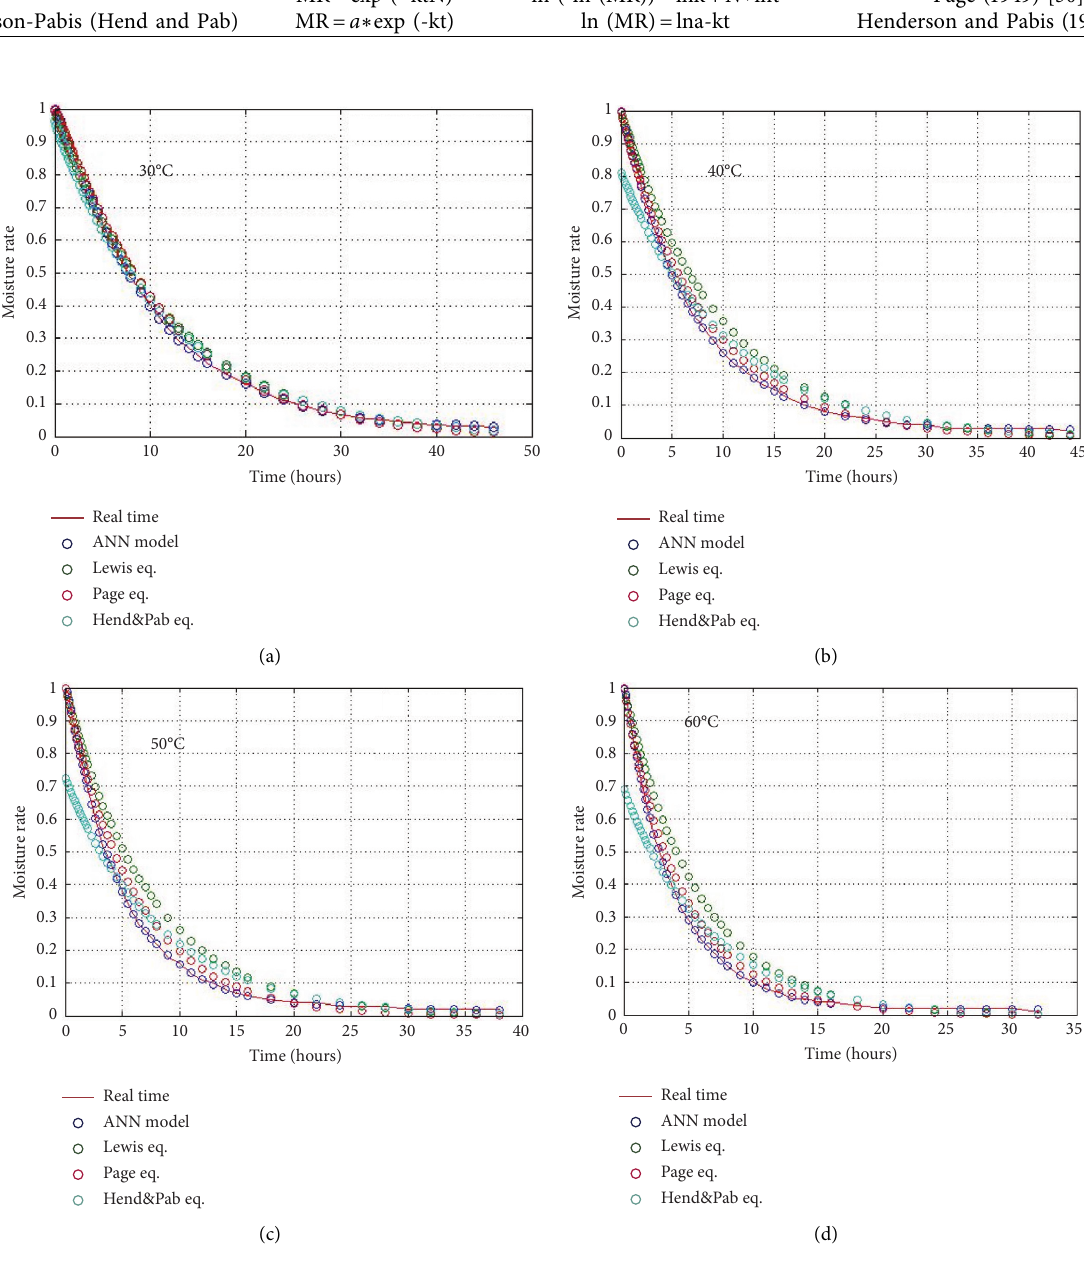
Figure 2: Experiment results for four drying tests under different temperatures. Color representation: Lewis (green), Page (red), Hend and Pab (blue), and ANN model